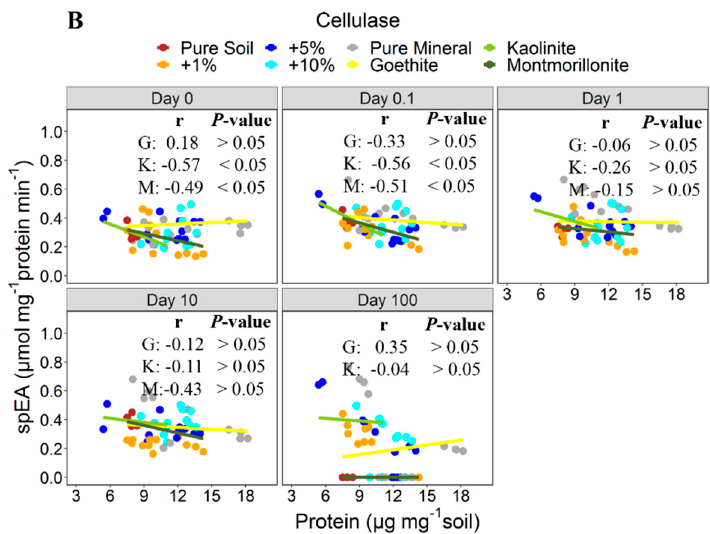
Figure 3. Specific enzyme activities (spEA) of amylase ( A ) and cellulase ( B ) normalized to the amount of adsorbed protein. Points represent the spEA in the pure soil, the mineral addition variants, and the pure minerals ( n = 4). Lines indicate trends in relationships with the protein contents based on types of minerals. G = goethite, K = kaolinite, and M = montmorillonite.